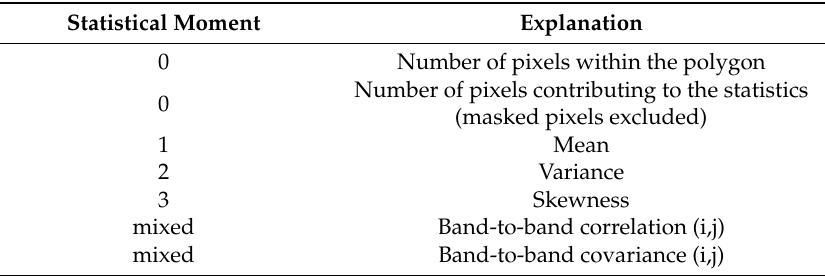
Table 4. Spectral statistical moments extracted from the images.